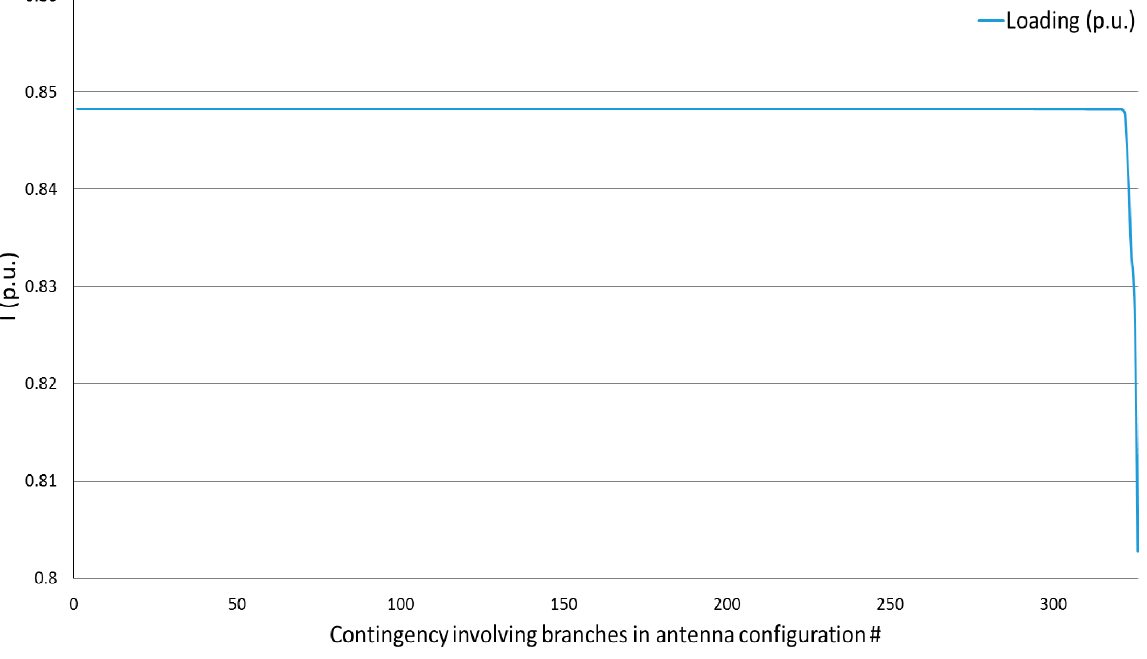
Figure 11. Comparison between maximum branch loadings (in per unit of the branch capacity) for the PDN standard configuration (blue line) and the 20 kV configuration (orange line).